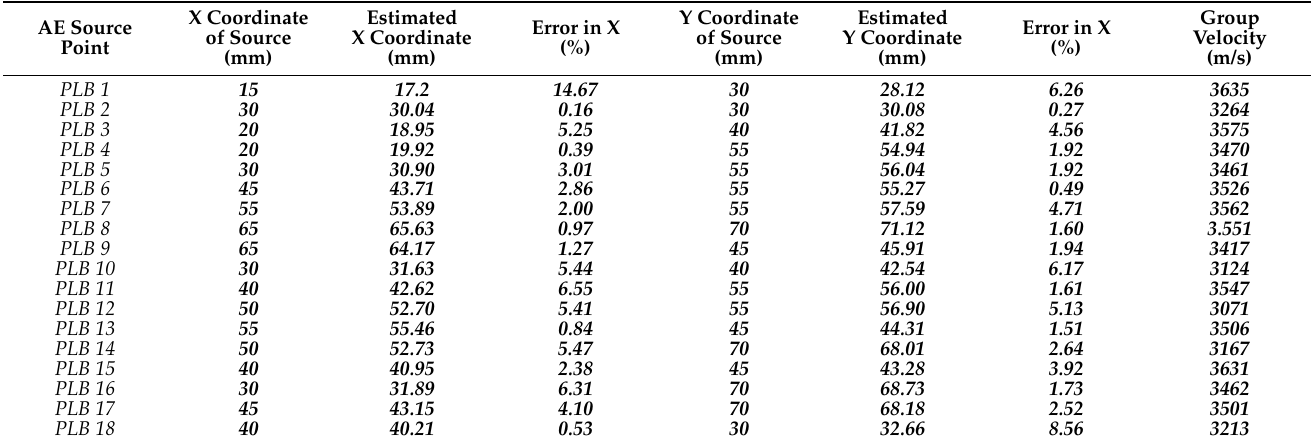
Table 1. Location data of the AE sources based on the EKF method and their corresponding group